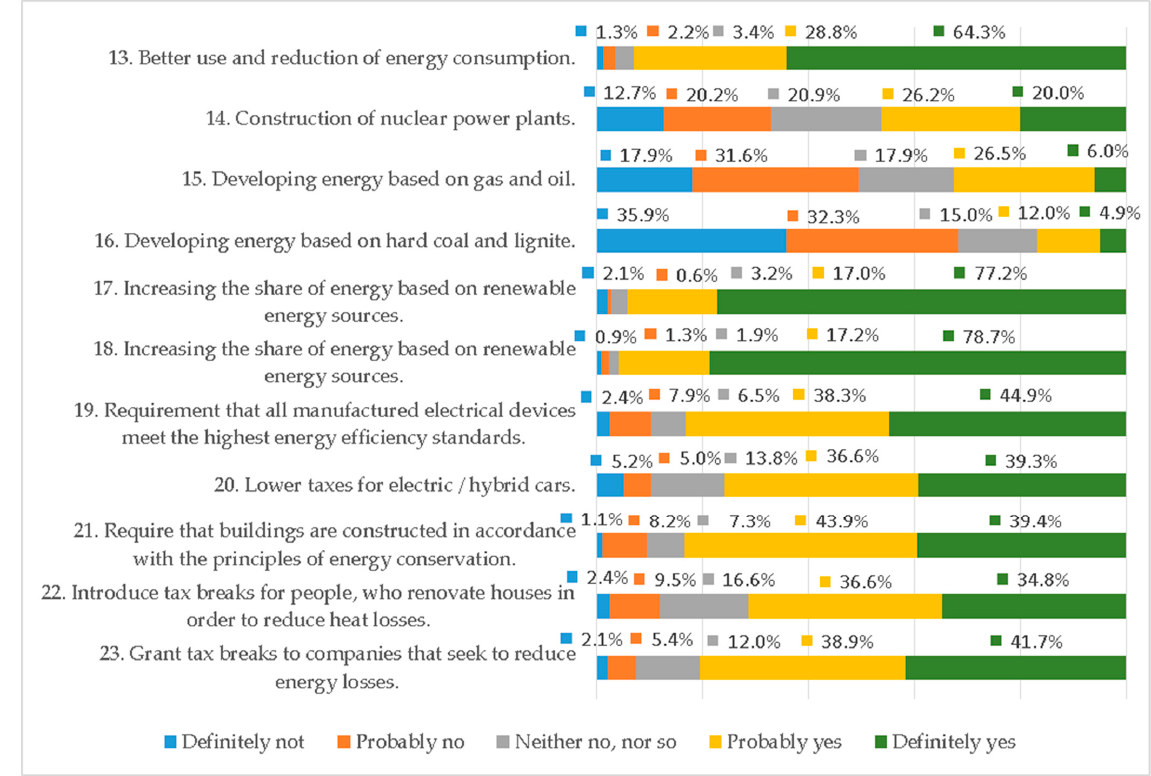
Figure 2. The structure of assessments of theses diagnosing the perception by adolescents of the directions of energy policy development and directions of state support.